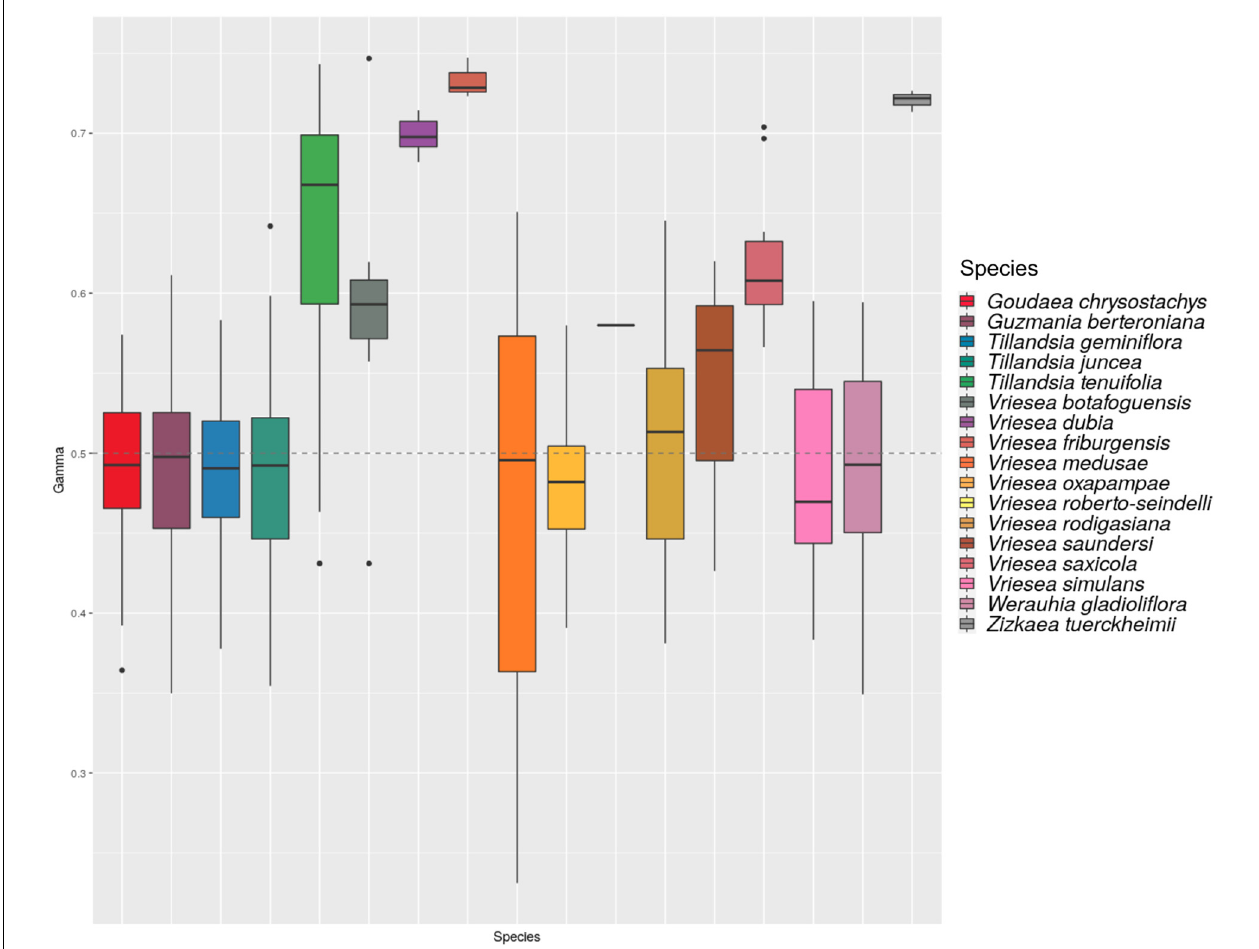
FIGURE 3 | Histogram of the distribution of the gamma statistics across all significant triplets for each detected species. The dashed line indicate the value for 50/50